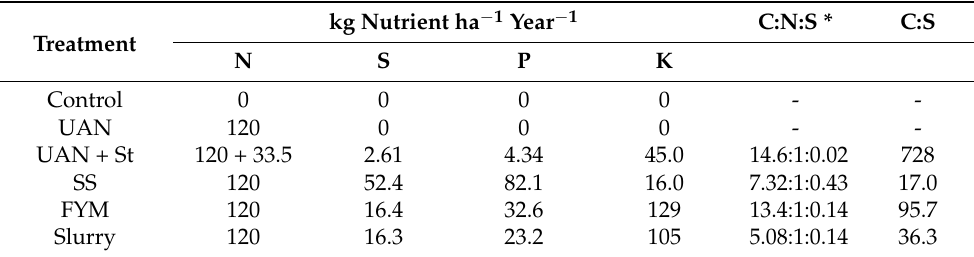
Table 3. Experimental design and nutrient inputs with fertilizers.